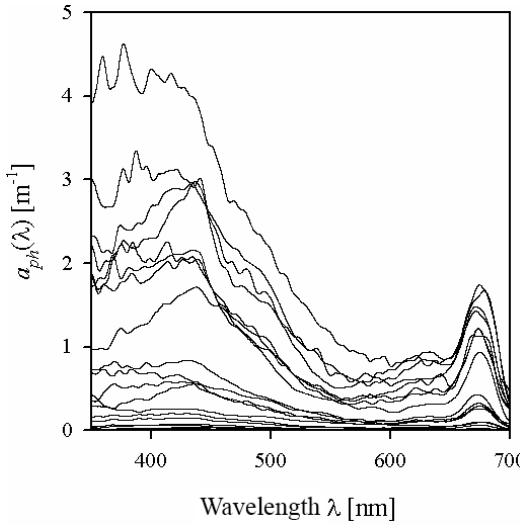
Figure 2. Examples of the spectra of the light absorption coefficient a ph (λ) representing the variability range of the data analysed in the present